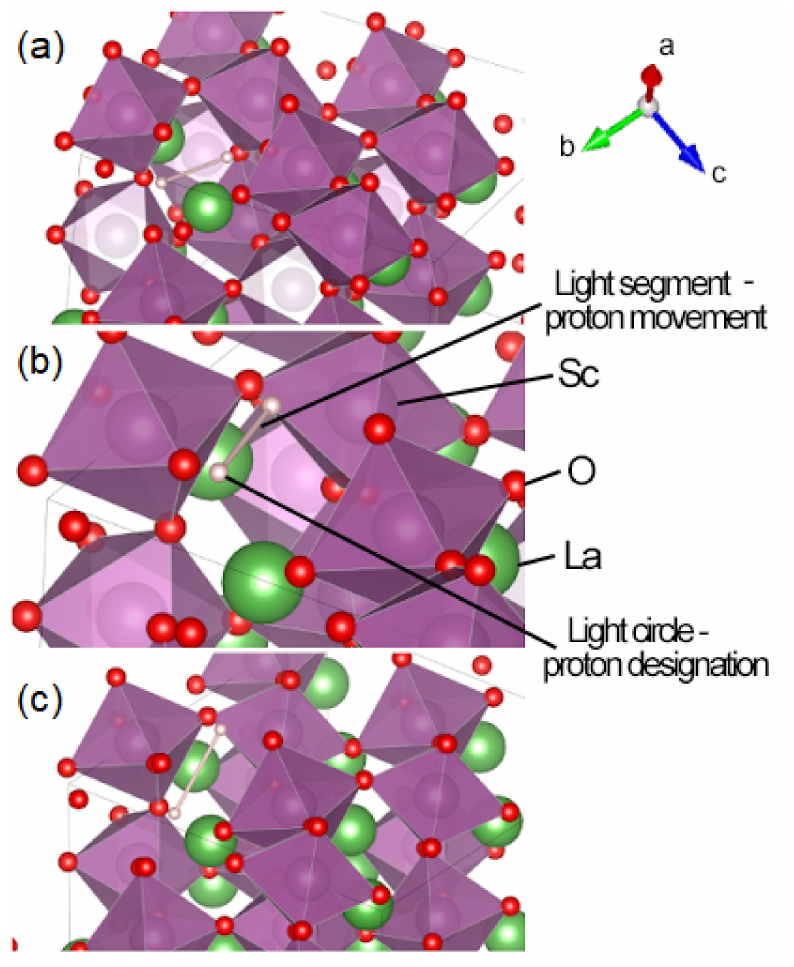
Figure 7. Types of proton jumps in perovskite ( a ) I, ( b ) II, ( c ) both, as III as